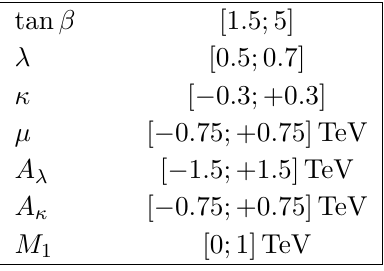
Table 1 . NMSSM parameter ranges used in NMSSMTools